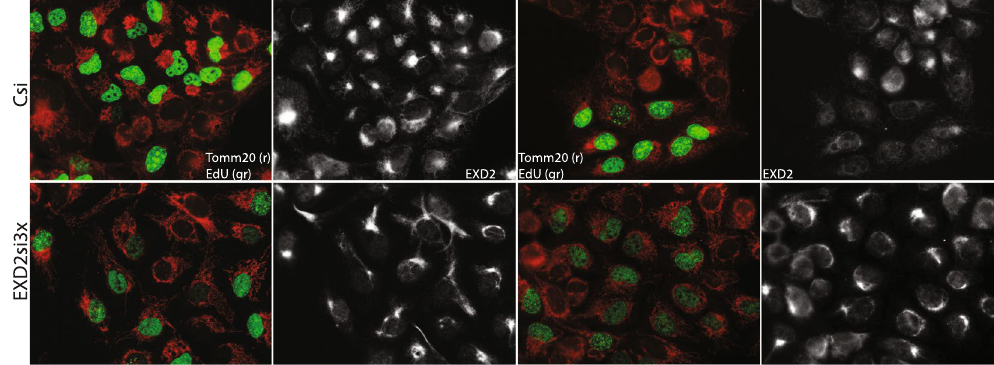
Figure 4. SiRNA mediated knockdown of EXD2 in U2OS cells results in a more widely spread mitochondrial network. In order to understand possible effects of EXD2 knockdown on mitochondrial network behaviour we labelled cells with EdU to identify cells in S-phase, in order to get a handle on mosaicism resulting from cell- cycle mediated effects on mitochondrial network dynamics (see main text). For this, cells were incubated for 30 min with EdU following transfection and 48–60 hrs incubation with either a pool of non-targeting control siRNAs (Csi) or a pool of three EXD2 stealth siRNAs (EXD2si3x). Following labelling for EdU incorporation (green, gr), cells were further labelled with antibodies for Tomm20 (red, r) and EXD2 (white). Control siRNA treated cells show frequent and strong perinuclear clustering of the mitochondrial network in particular in EdU positive cells. In contrast, the EXD2si3x typically show a more distributed and sometimes more hyperfused network. Two fields of view are shown for each